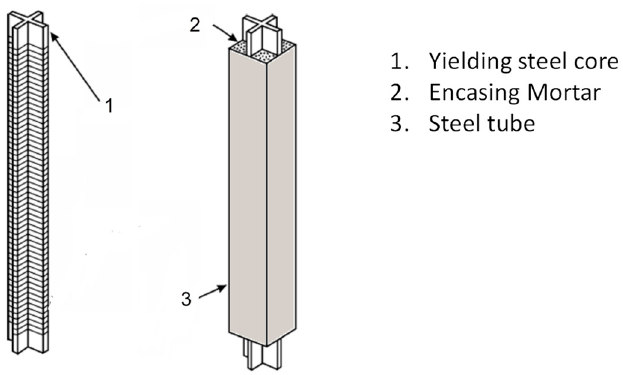
Figure 11. Construction of a buckling-restrained brace.